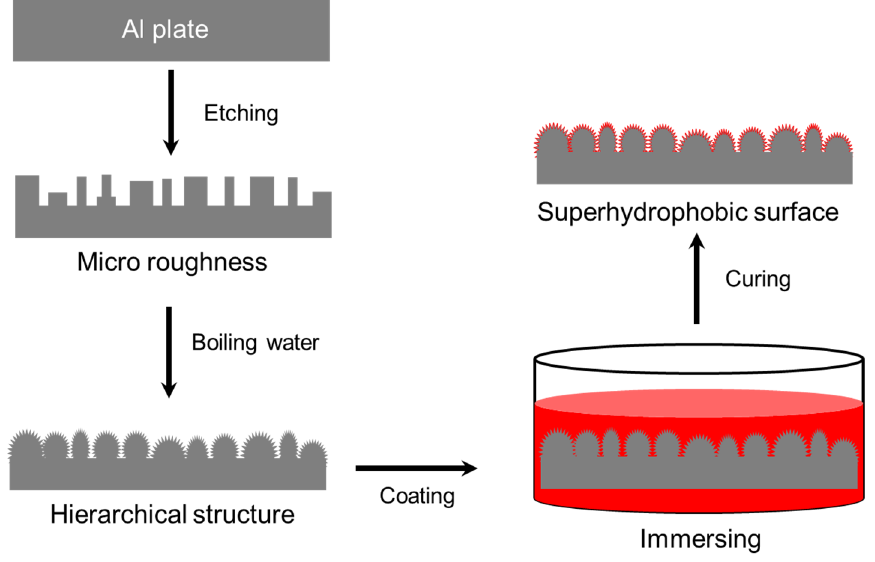
Figure 3. Schematic of the fabrication of superhydrophobic Al surfaces with micro-nanostructure.